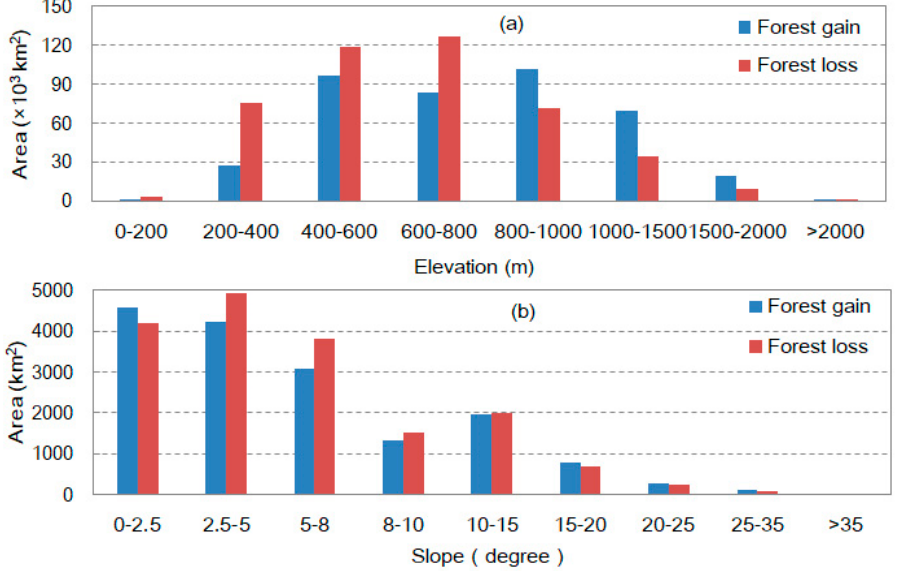
Figure 8. Changes of forests under different topographic gradient: elevation ( a ) and slope ( b ).